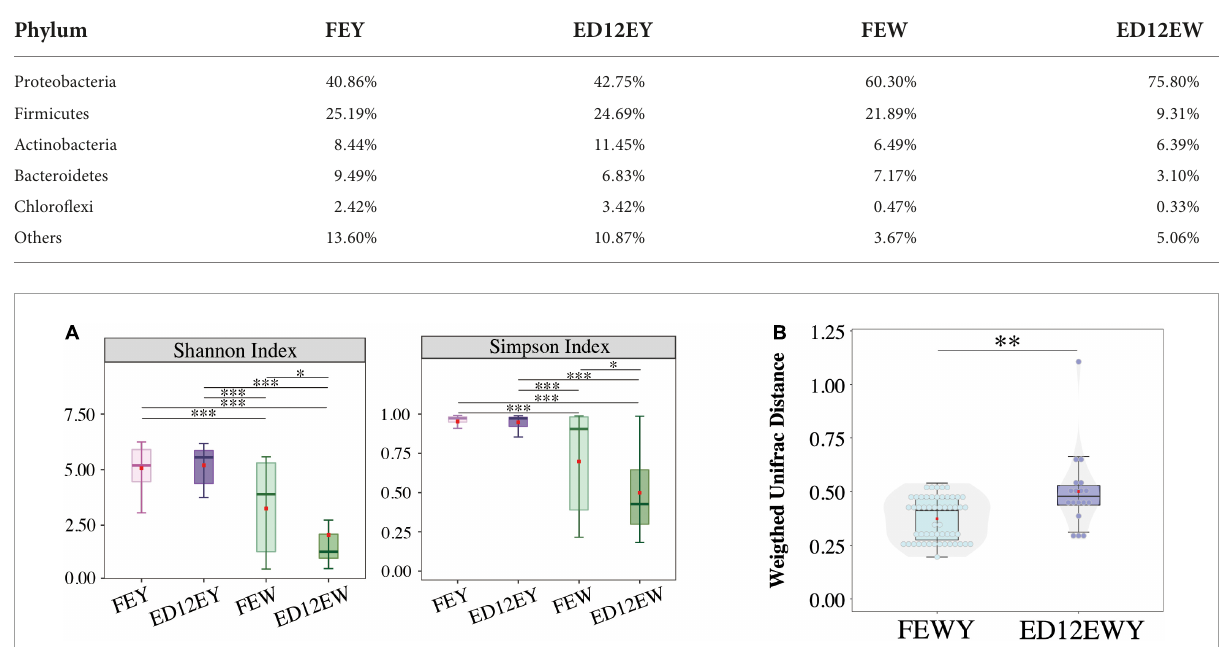
TABLE 2 Relative abundance of microbial phyla in egg yolks and whites at different periods.